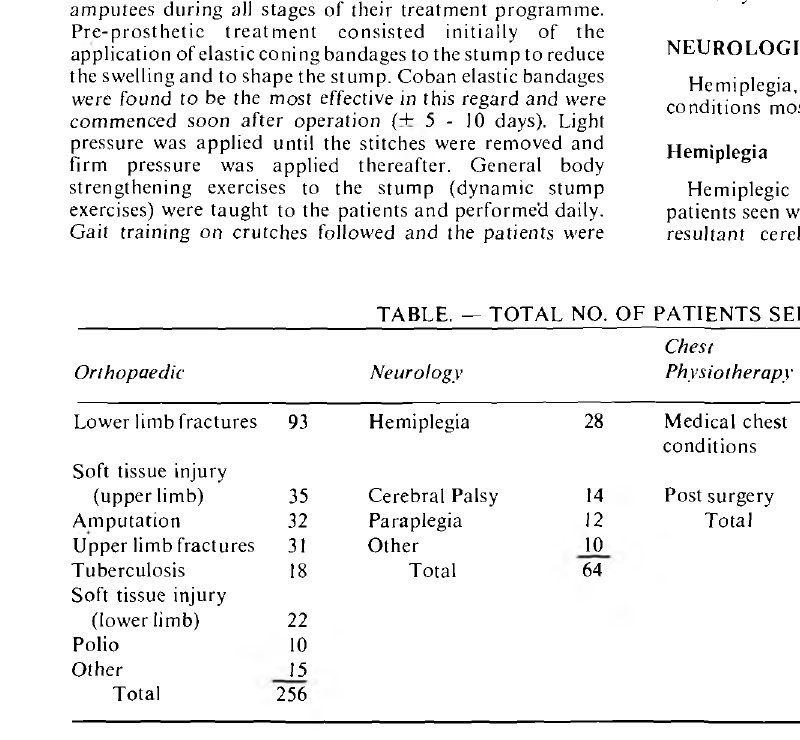
TABLE. — TOTAL NO. OF PATIENTS SEEN —